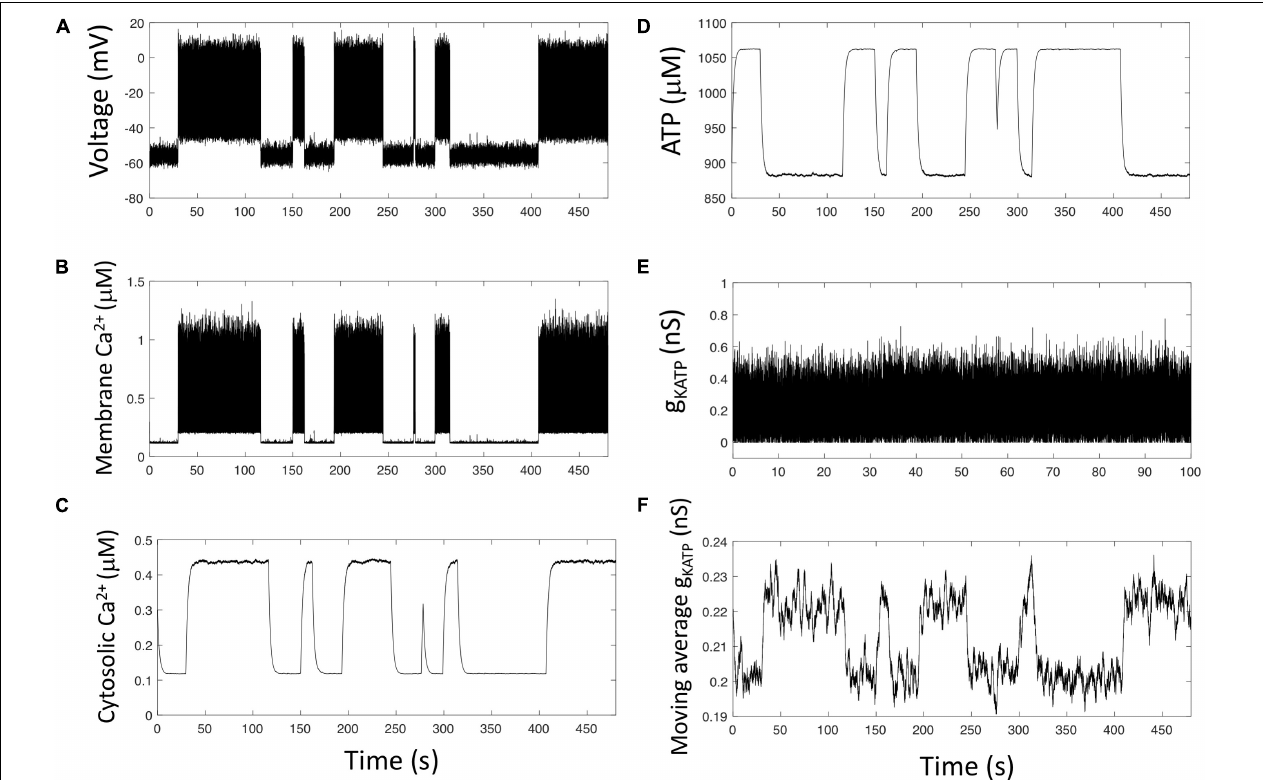
FIGURE 4 | Simulations predict that changes in membrane ATP and stochasticity in the K ATP current generate slow Ca 2 + oscillations. (A–E) Numerical simulations of Model 3 (see section “Outline of the Modeling Approach”) that describes the opening and closing of the K ATP channel by a Langevin stochastic equation and takes into account the consumption of ATP by PMCA as well as the inhibition of K ATP channels opening by ATP. (F) The moving average of g KATP allows to visualize that, although highly random, g KATP tends to increase when ATP concentration is low and to decrease when ATP concentration is large. There are thus long-lasting trends in g KATP changes that can induce robust changes in α -cells electrical activity. Values of g KATP are averaged on a 200 s period.